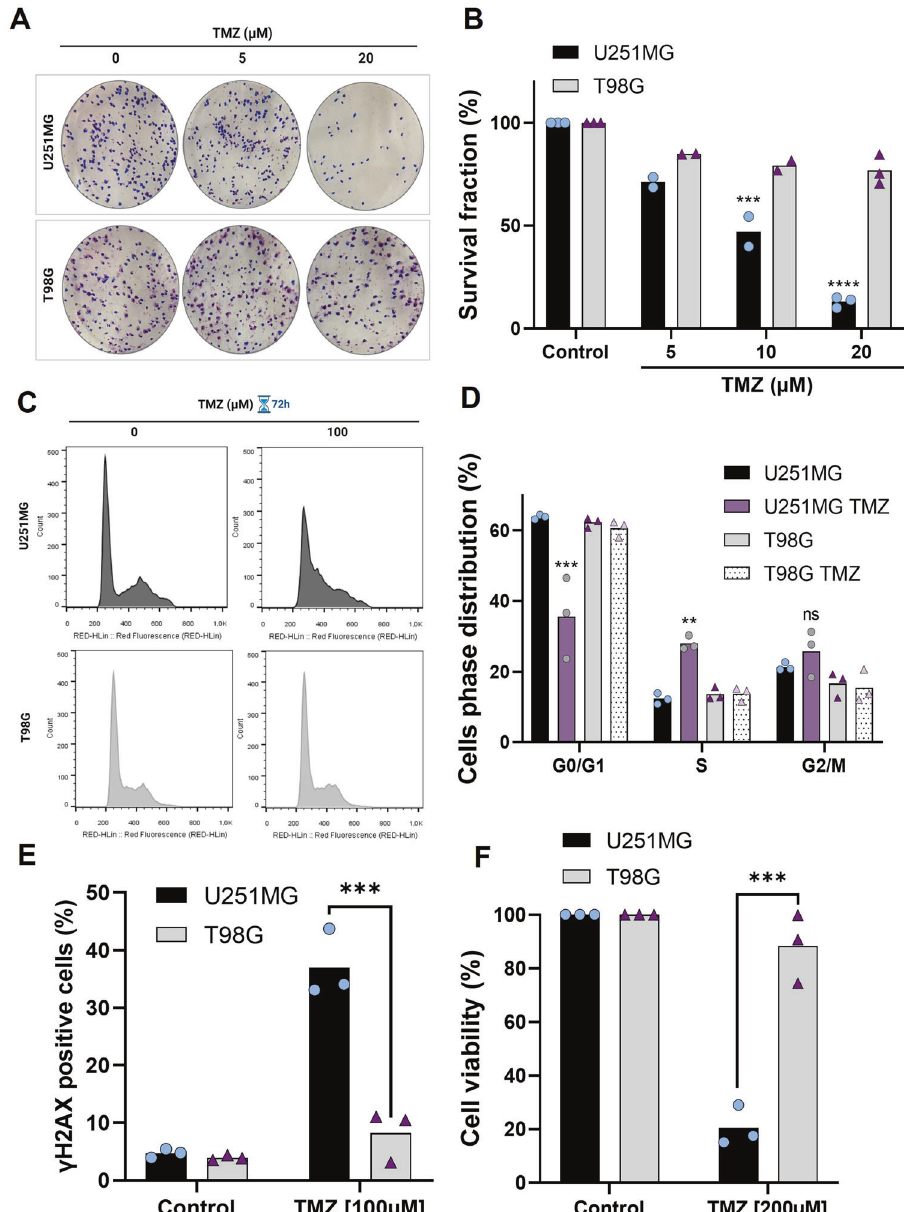
Fig. 1 Differential response of glioma cells to TMZ treatment. A Representative images of colonies formed in each group treated with 5 and 20 µM TMZ. B Quanti fi cation of total colonies after TMZ treatment (5, 10, and 20 µM) in comparison to controls. C Histograms represent cell cycle distribution with TMZ treatment for 72 h. D Cell cycle distribution was conducted by fl ow cytometer analysis after TMZ treatment (100 μ M) for 72 h. E Flow cytometry analysis of the percentage of γ H2AX positive cells upon treatment with TMZ (100 μ M) for 48 h. F Cell viability was analyzed 120 h after treatment with TMZ (200 μ M) and measured by XTT assay. Values are mean ± SEM of three independent experiments, ns = not statistically signi fi cant, * P < 0.05, ** P < 0.01, *** P < 0.001, **** P < 0.0001. Each dot represents an independent